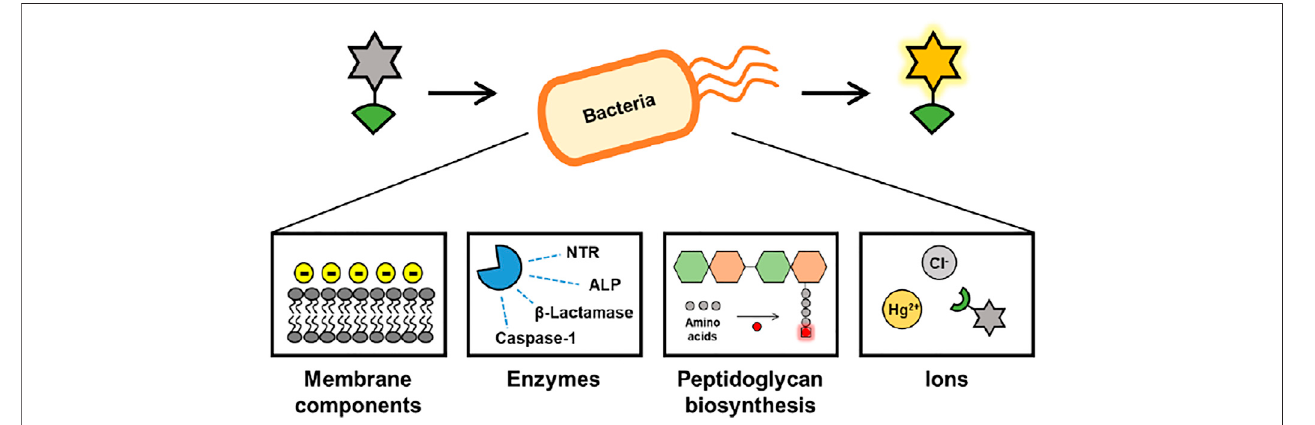
FIGURE 1 | Overview of this